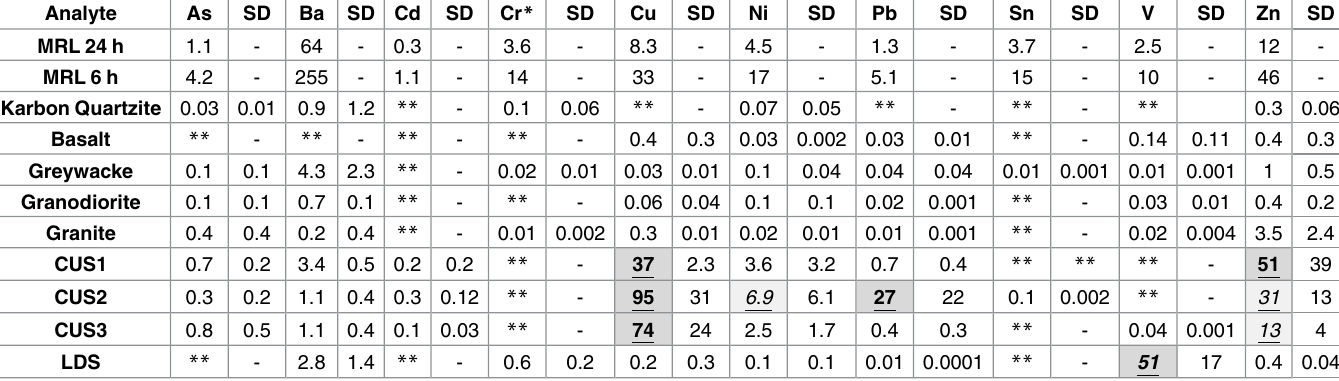
Table 2. Mean release values [mg/m 2 /64d] of n = 5 DSLTs (Lab2; S1 File, Table B-H, SD = standard deviation of independent tests) compared to MRLs. Values > low frequency exchangeMRL = italic, underlinedand light grey; values > high frequencyexchangevalue 6 h = bold, underlinedand dark grey, * EQS Cr(III) ** < LoQs; the LoQs are given in S1 File, Tables B-H for the respectiveelements. Analyte